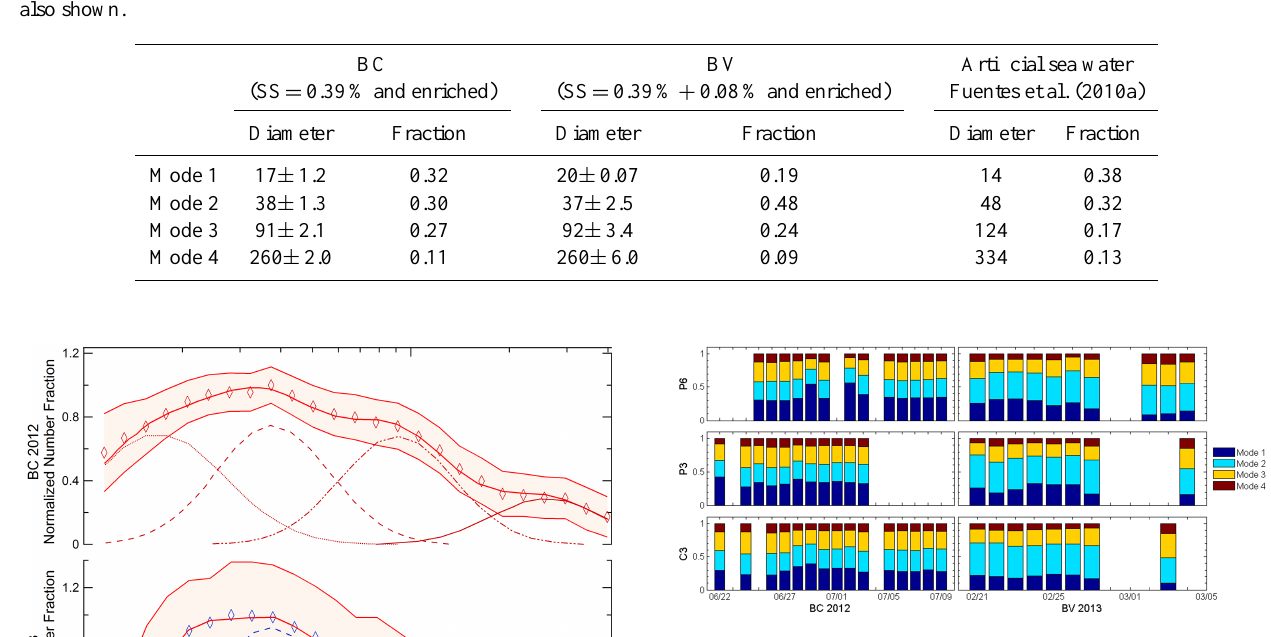
Figure 2. Number fraction of DMPS lognormal modes from all mesocosms (SS = 0.39%) at BC and